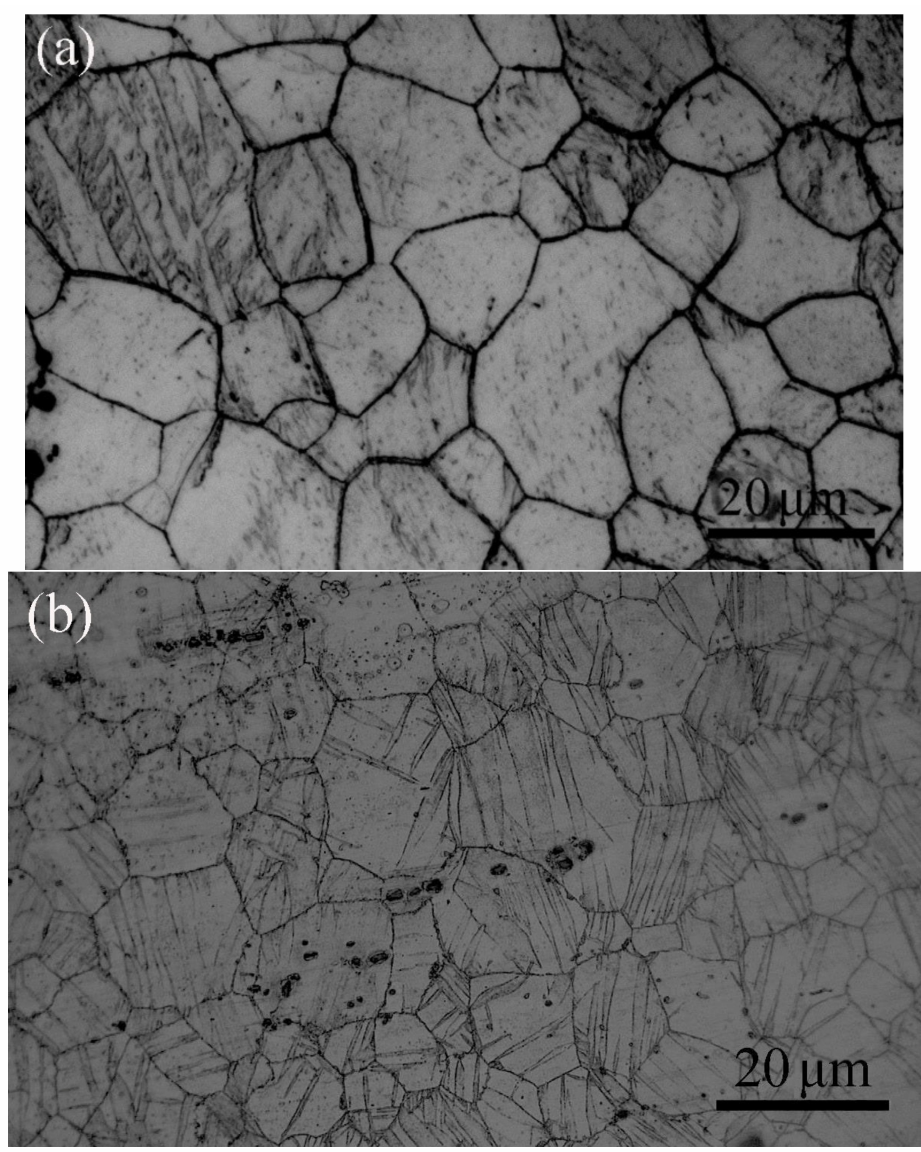
Figure 3. ( a ) The microstructure of the AZ61 alloy subjected to a compressive stress of 155 MPa and ( b ) the microstructure of sample subjected to a compressive stress of 175